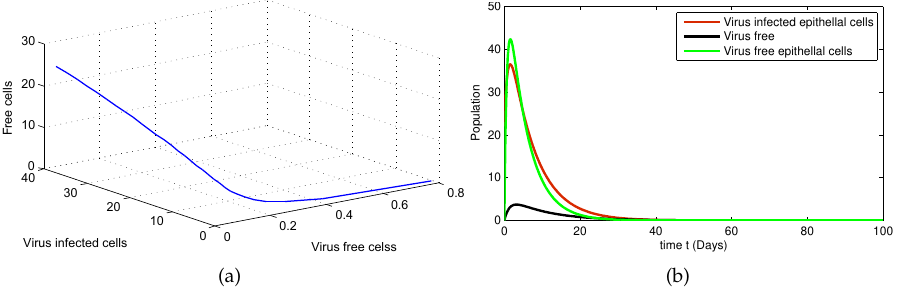
Figure 2. Simulation of the numbers of E p , I p , and F when R 0 < 1 with ( a ) three-dimensional plot and ( b ) two-dimensional